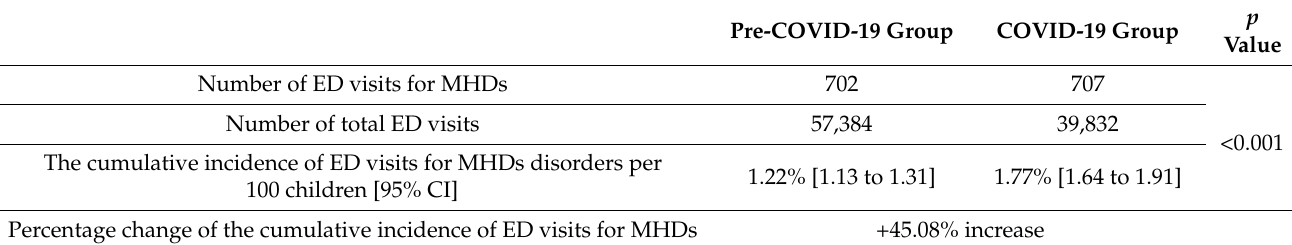
Table 1. The frequency of ED visits for MHDs among adolescents, and the change in the frequency before and during the COVID-19